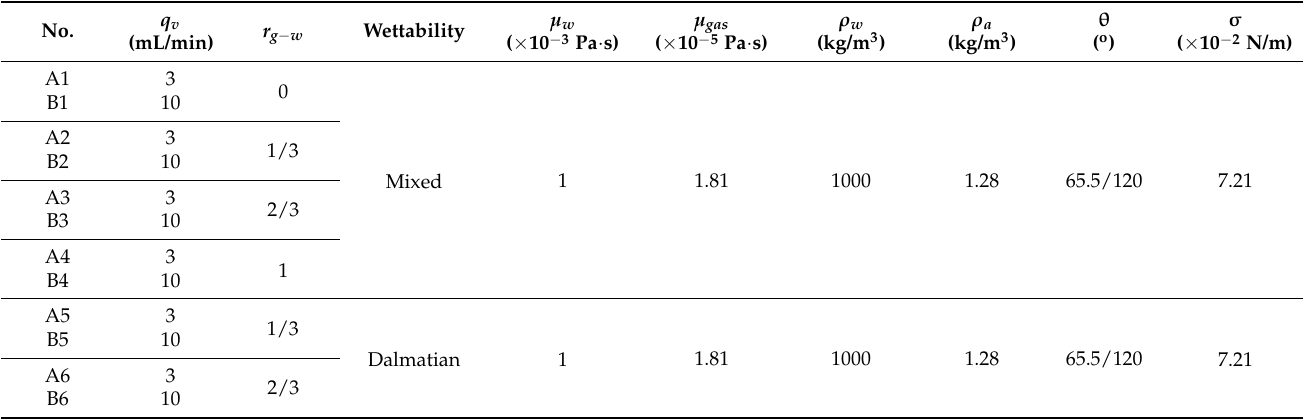
Figure 5. Model geometry and boundary conditions.